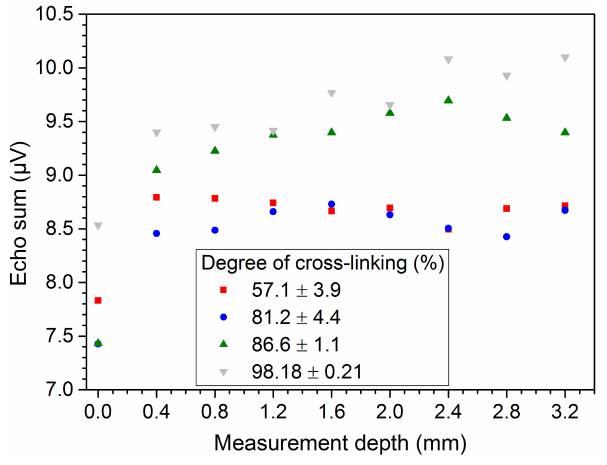
Figure 9. Depth profiles of PE-Xa samples with different degrees of cross-linking measured in the